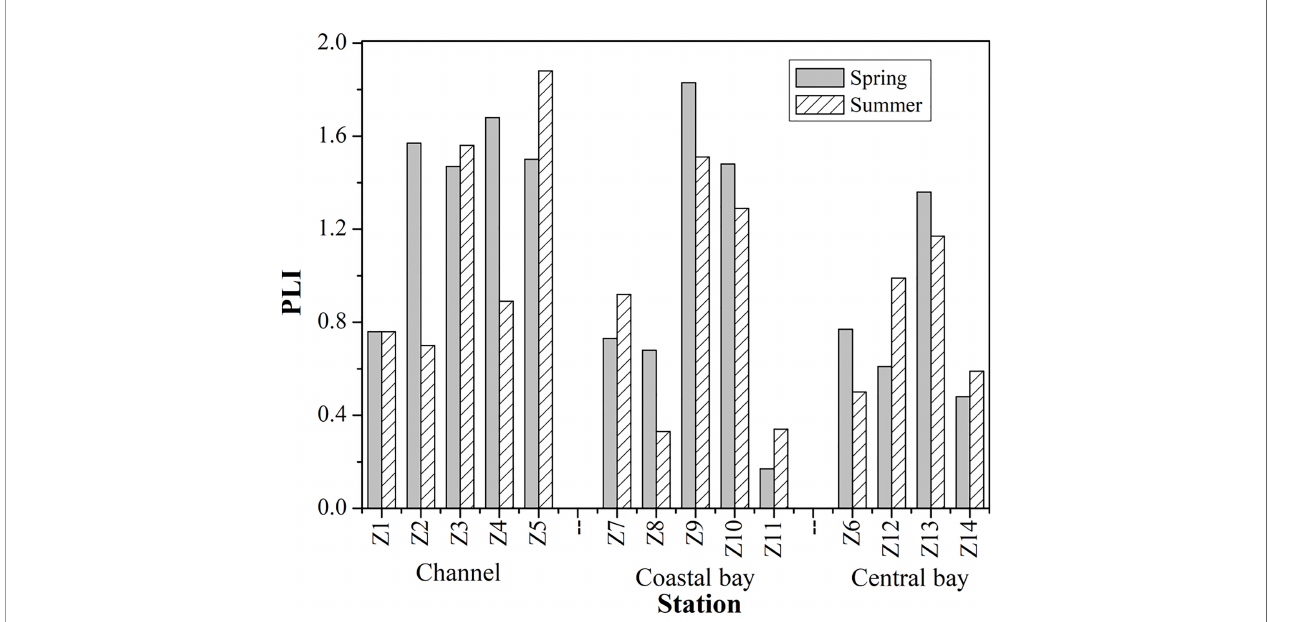
FIGURE 8 | Distributions of pollution load index (PLI) for metals in surface sediments of Zhanjiang